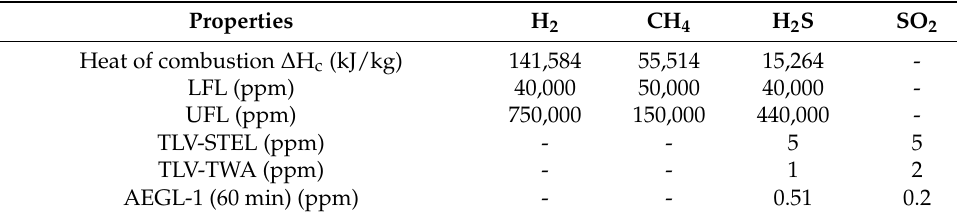
Table 1. Properties of the involved agents by NIST database